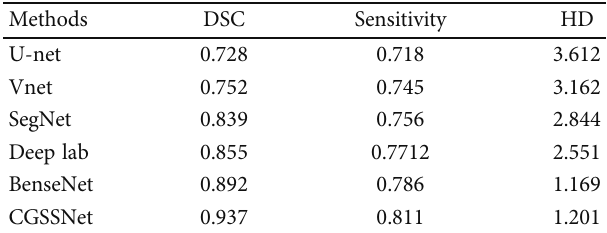
Table 2: Comparison of the di ff erent segmentation algorithms of DSC, sensitivity, and